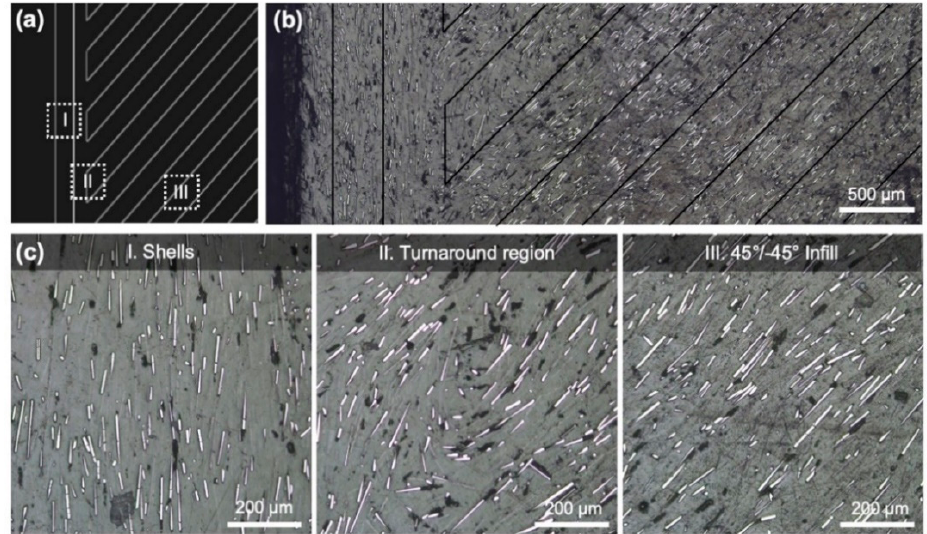
Figure 3. ( a ) Eiger 2D part showing variations of chopped carbon fiber alignment in the bulk (infill), turnaround, and shell region of the part. ( b ) Microscopy image of a polished cross-section with black lines added to indicate the tool paths. ( c ) Close-up microscopy image of fiber alignment in each corresponding